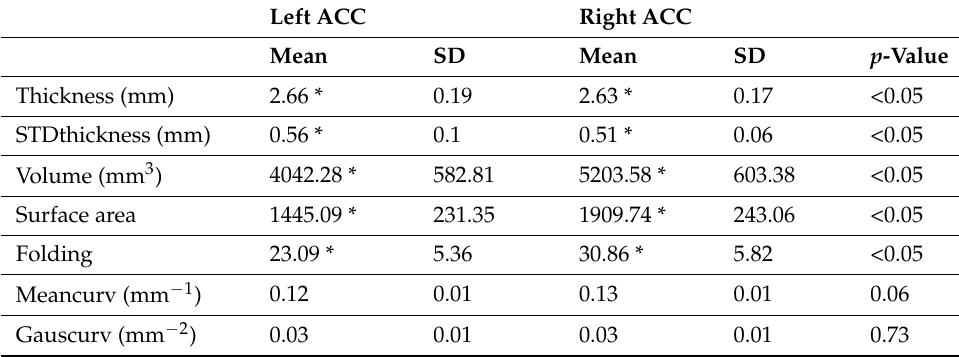
Table 4. Differences of surface morphological parameters in laterality. Left